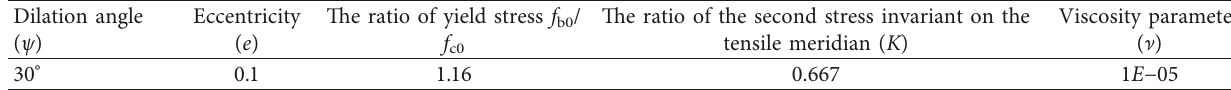
Figure 5: Stress-strain curve of concrete. (a) Destructive strain curve. (b) Cracking displacement curve. Table 1: Values of the plastic parameters for the CDP model.